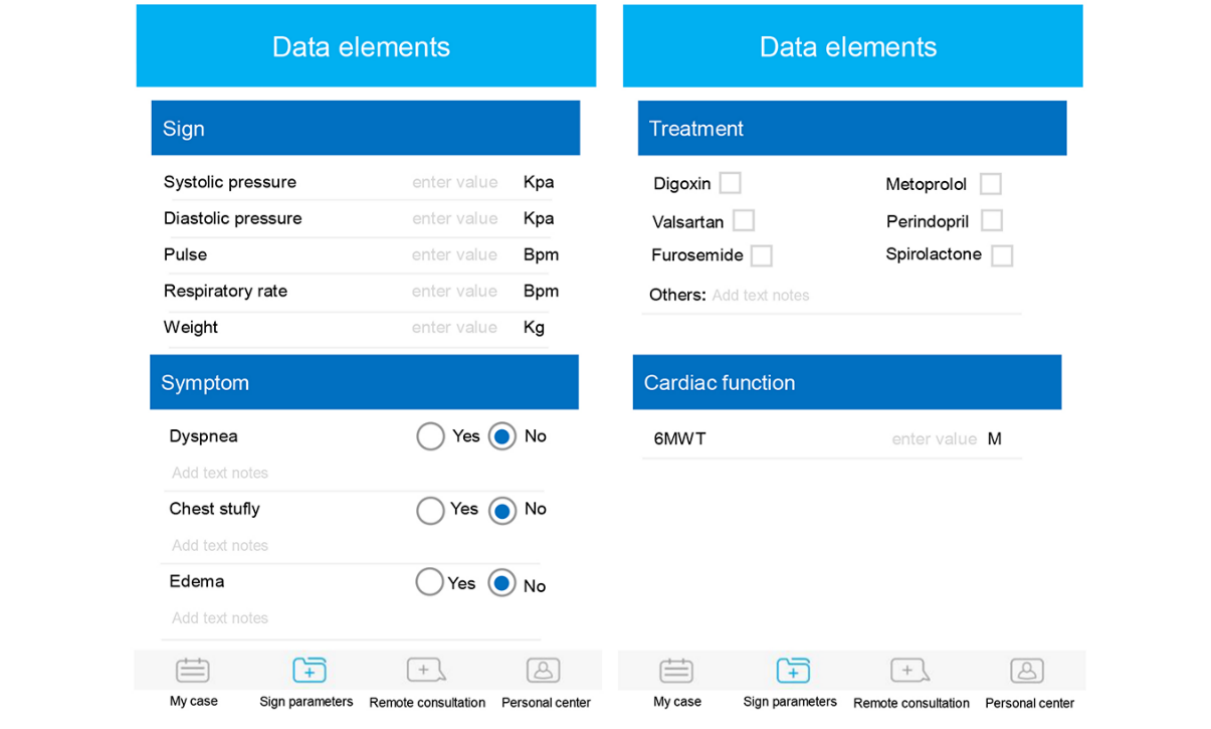
Figure 1. Screenshots from the mobile app of